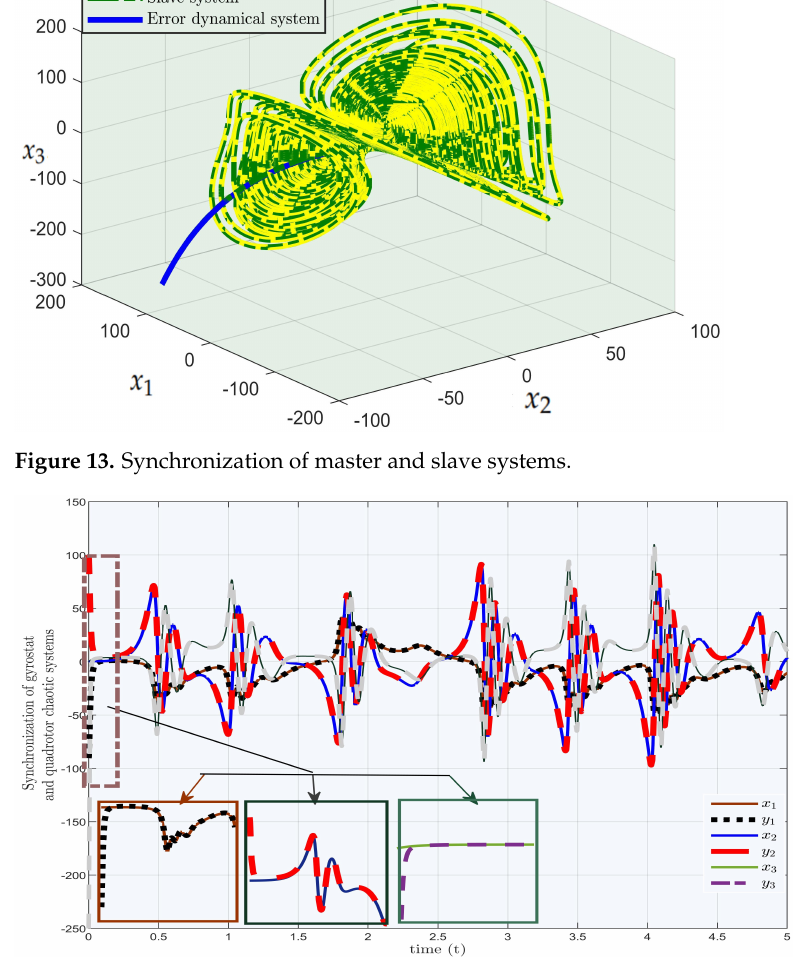
Figure 14. Time history of master and slave